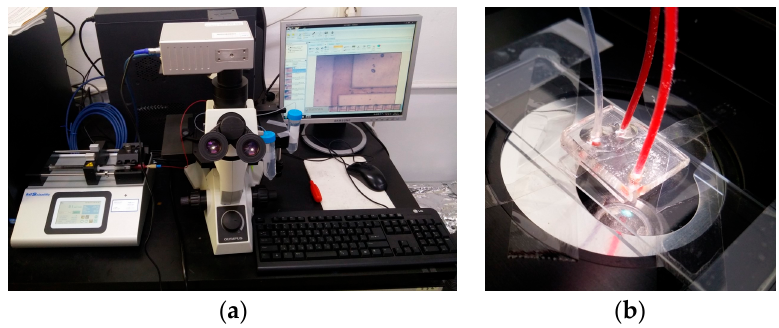
Figure 7. Photographed images of the ( a ) experimental setup for blood plasma separation and ( b ) fabricated all-glass bifurcation microfluidic chip during blood plasma separation.